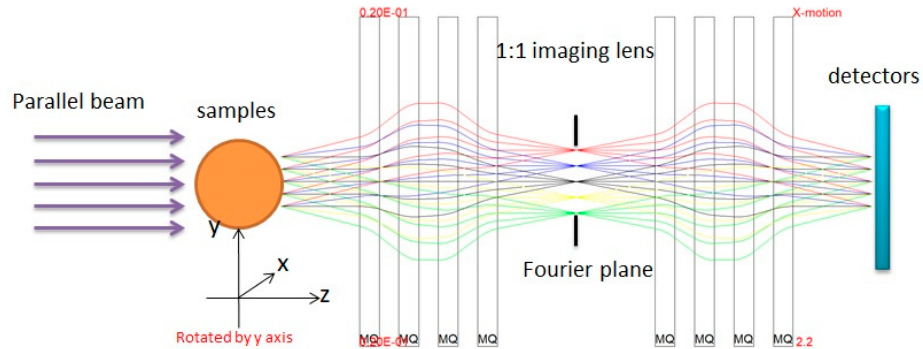
Figure 1. The sketch map of high-energy electron radiography (HEER) and three-dimensional high-energy electron radiography (TDHEER) with a parallel beam.